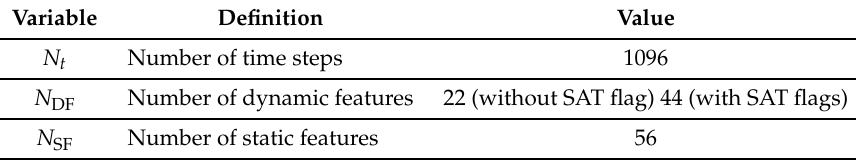
Table 3. Definitions of feature and label vector with dimensions for the LSTM (dynamic) input ( X D